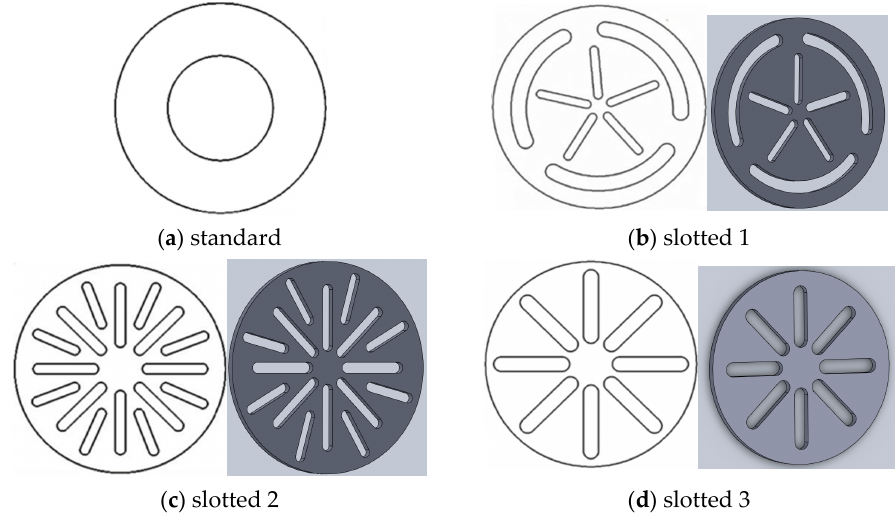
Figure 3. Orifice plates utilized in the experimental